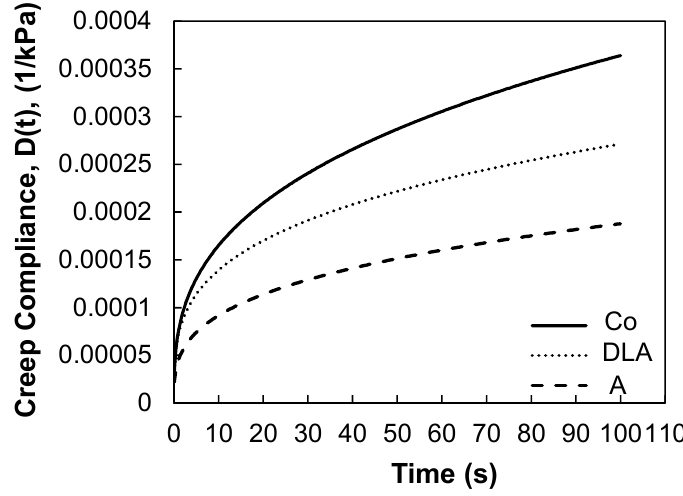
Figure 9. Average creep compliance of Co, A, and DLA samples. Figure 10. An ANOVA and statistical t -test analysis were carried out at a 95% confidence level for creep compliance data at 2.4, 5, 10, 20, 50, and 95 s for each of the three replicates of the three mixtures: Co, A, and DLA. The ANOVA analysis was used to compare